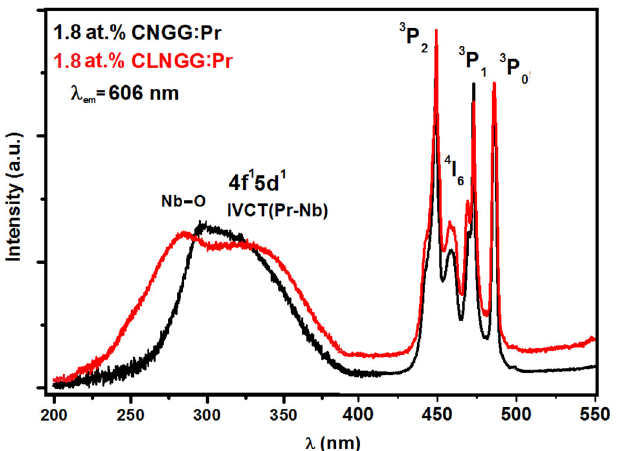
Figure 11. Excitation spectra of Pr 3+ ions in CNGG:Pr and CLNGG:Pr crystals. (Reprinted with permission from Ref. [24], copyright 2019, Elsevier).